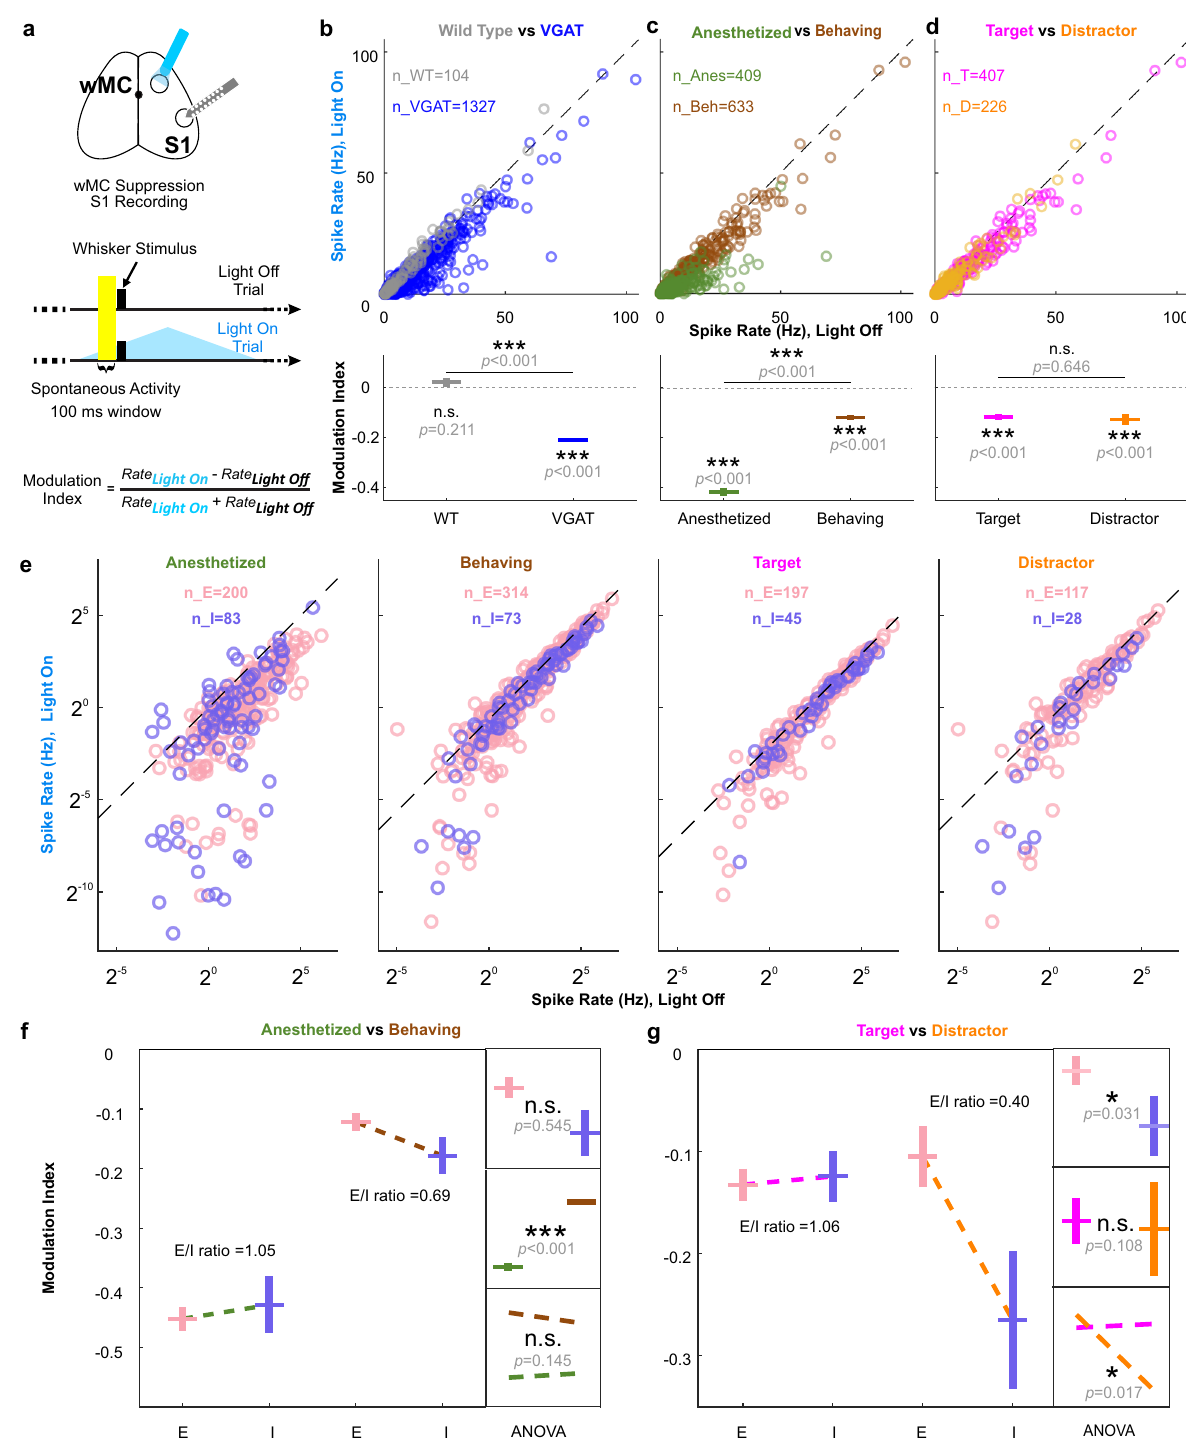
as the MI of excitatory neurons divided by the MI of inhibitory neurons. E/I ratio for anesthetized and target-aligned conditions were remark- ably balanced, yielding ratios near 1. In contrast, the distractor-aligned E/I ratio was 0.40, re fl ecting a preferential drive of wMC onto putative inhibitory neurons (Fig. 5g). Two-way ANOVA analyses supported these conclusions, yielding a signi fi cant main effect for behavioral context comparing anesthetized and awake behaving conditions (anesthetized vs awake, p =1.2×10 − 24 ) (Fig. 5f). Comparing target- aligned and distractor-aligned conditions, we found a main effect for cell-type ( p =0.031) and an interaction effect between alignment